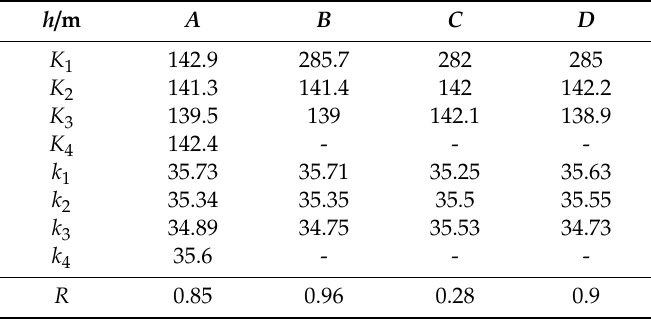
Table 11. 1.0 Q head